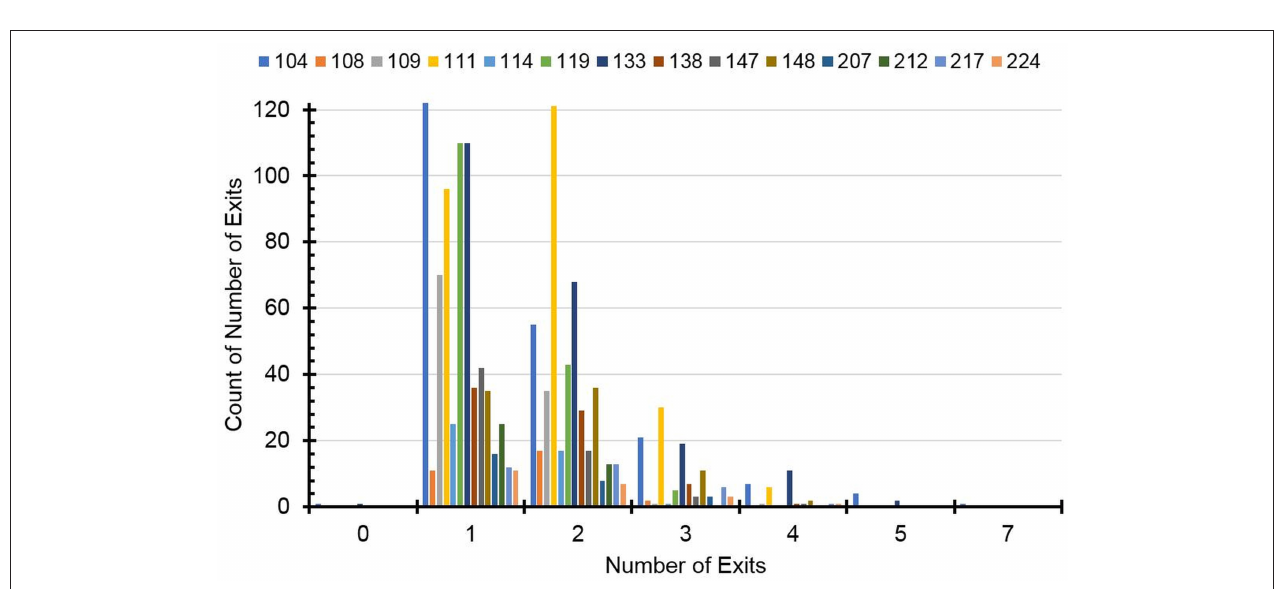
FIGURE 3 | Distribution of the number of exits of individual